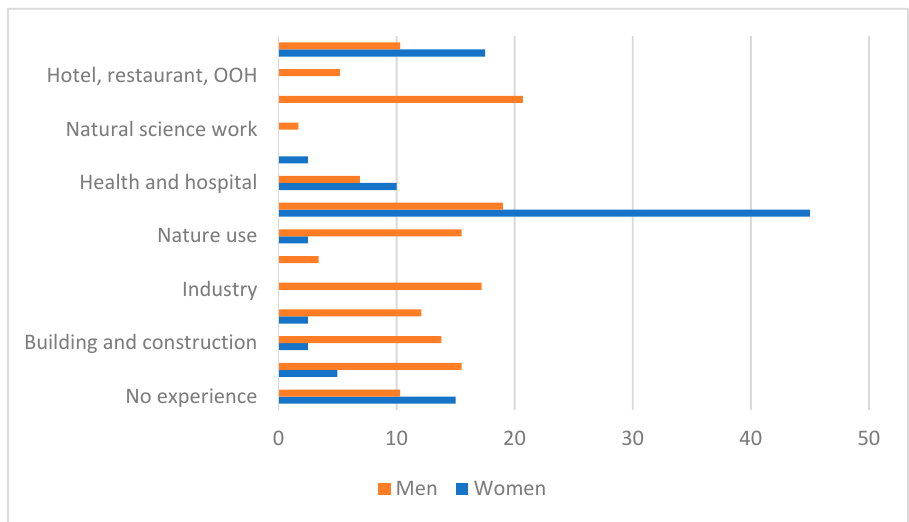
Figure 2. Work experience of highly-skilled men and women ( N = 98) with refugee experience before coming to Sweden.